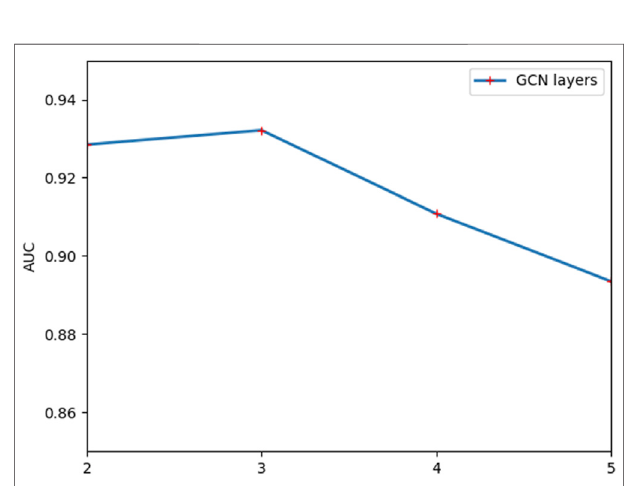
FIGURE 4 | Outcome of comparing various GCN layers.